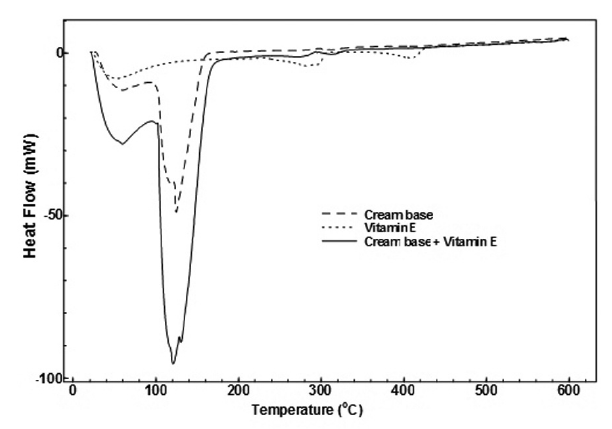
FIGURE 3 - DSC Curves of cream base, vitamin E and cream base with vitamin E samples obtained in N2 dynamic atmosphere (50 mL min -1 ) and heating rate of 10 ºC min -1 .